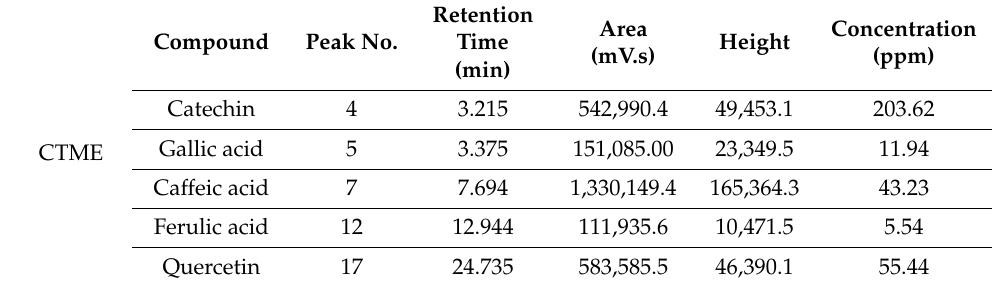
Table 1. HPLC analysis of Caralluma tuberculata